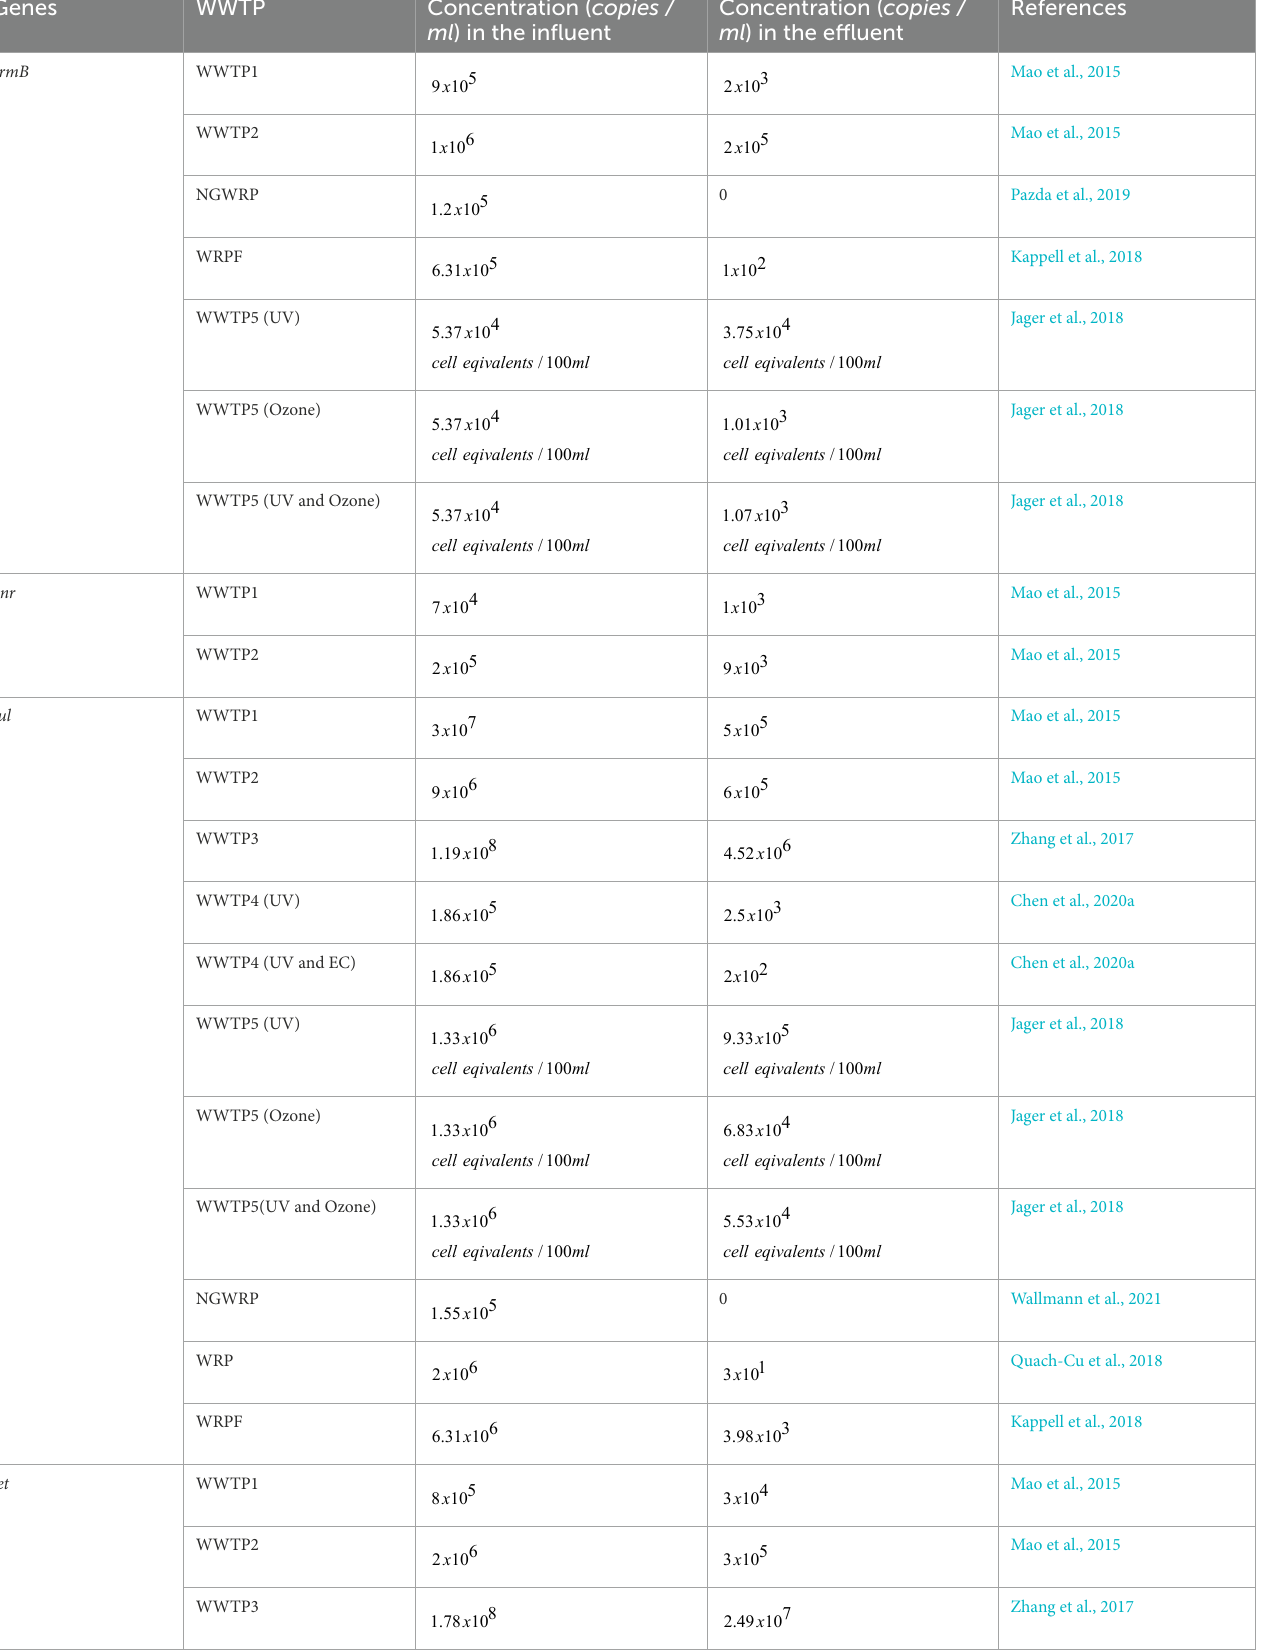
TABLE 1 Concentration of genes in the influent and effluent of different WWTPs. Genes WWTP Concentration ( copies /